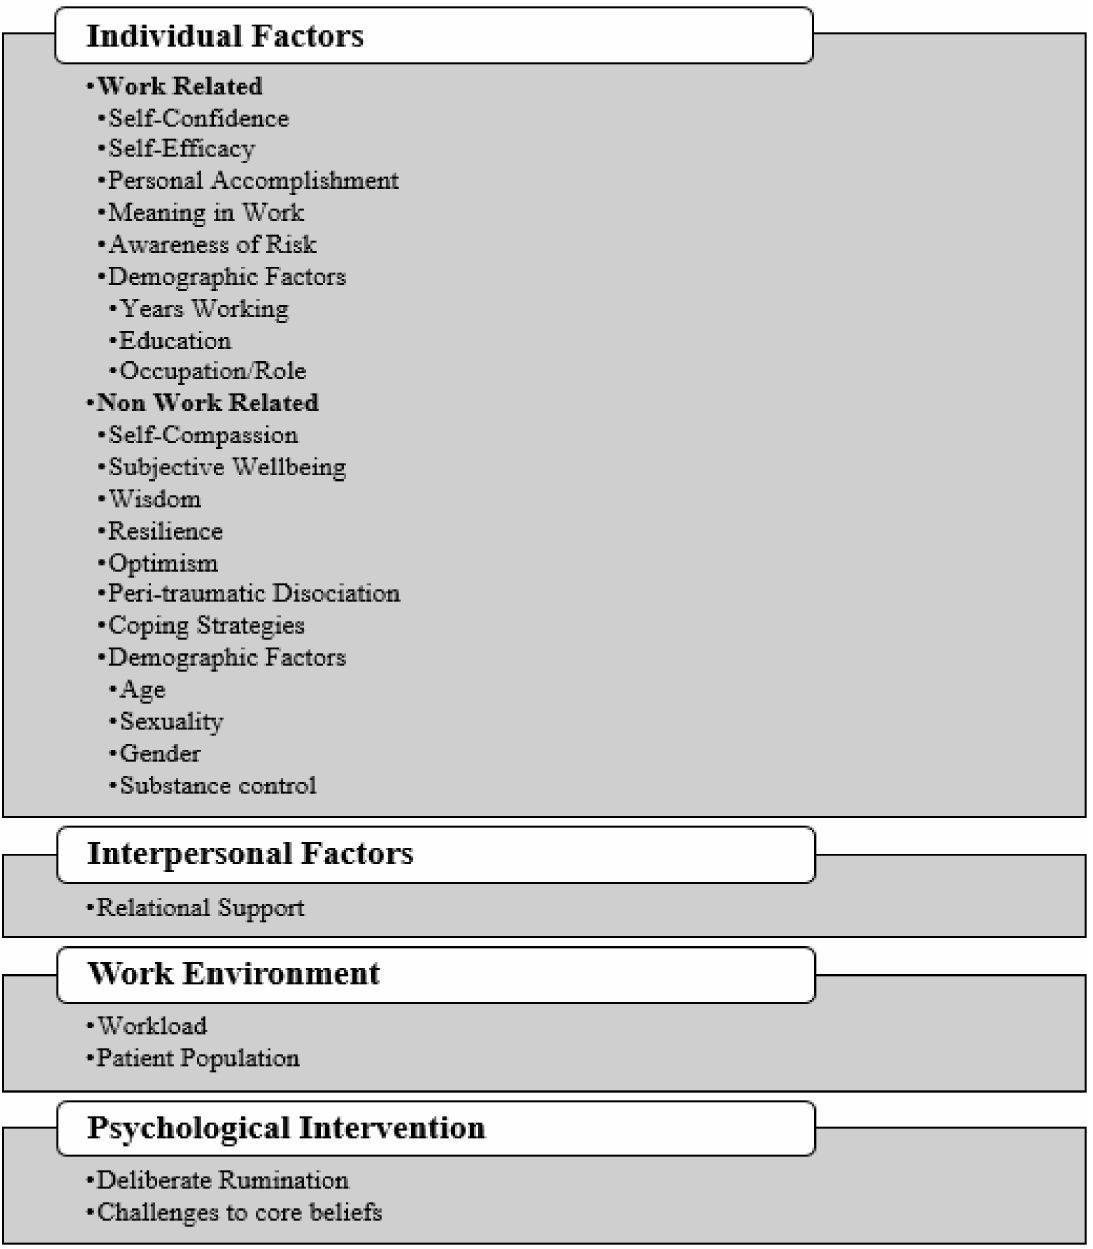
Figure 2. Categories of Identified PTG